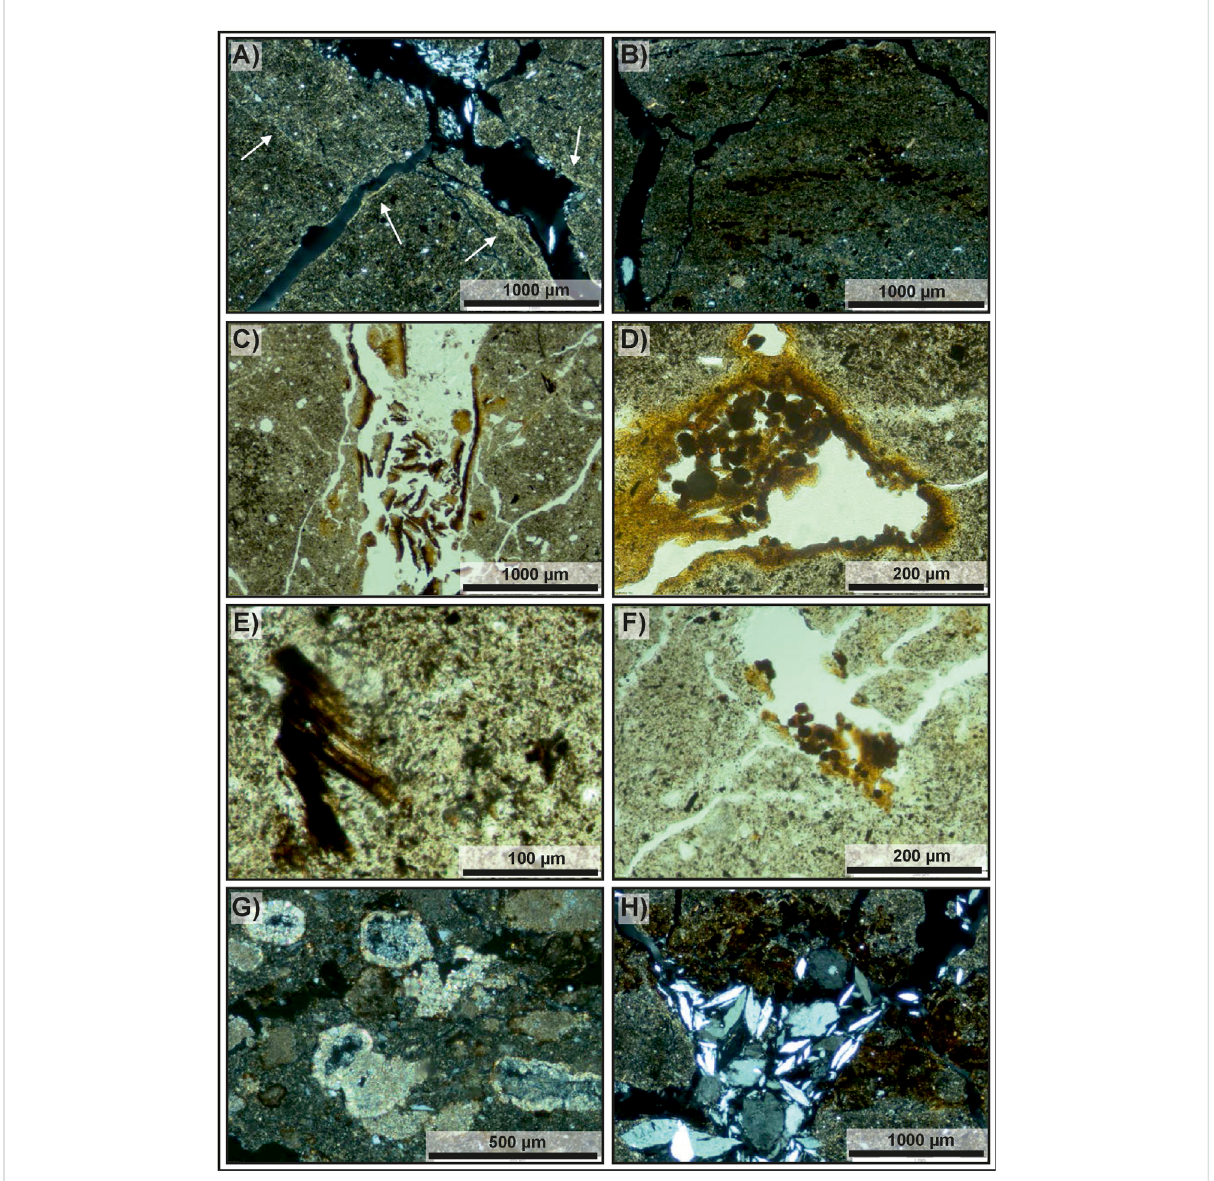
FIGURE 7 Lowersample(l): (A) Porostriationalong fi ssures(arrows)resultingfromstress(argilloturbation)duetoswelling-shrinking.Somegypsumlenses occur at the top as loose discontinuous in fi llings. (B) Upper part of the reduced material, with layered sorting of particle sizes and subhorizontal organicintercalations. (C) HypocoatingofFe-oxihydroxidesalongapore(darkline)thathasbeenbrokenbyswelling-shrinking(argilloturbation) and isseennowasin fi llingoffragmentstogetherwithgypsumlenses. (D) HypocoatingsofFe-oxihydroxidesaroundpores,andloosein fi llingofiron spheres,pseudomorphsafterpyriteframboids.Someofthepseudomorphsshowlusterunderincidentlight,whichindicatesthatpyriteoxidationhas not been complete. Upper sample (u): (E) Dark inclusions in the groundmass corresponding to particulate organic matter. (F) Loose discontinuous in fi lling of Fe nodules, pseudomorphs after pyrite framboids developed on organic materials. (G) Geodic nodules of sparite. (H) Loose